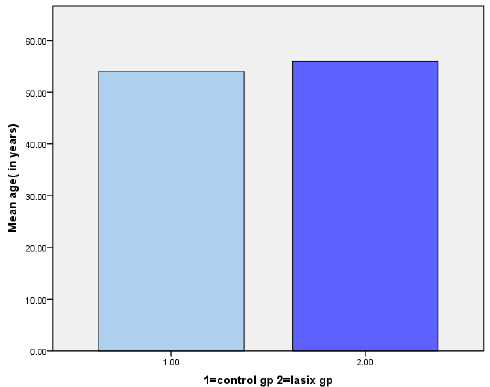
Figure (1): shocked patients received normal saline versus shocked patients received Furosemide in terms of age, there is no significant statistical difference (p=0.267).